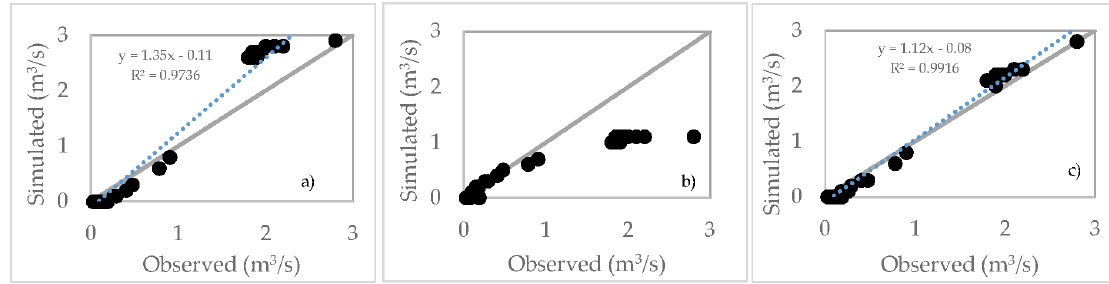
Figure 9. Plot of predicted against observed discharge hydrograph using the first ( a ), the second ( b ), and the third simulations ( c ). Grey line: 1:1 line; dotted blue line: linear relation between the simulated and observed hydrographs.